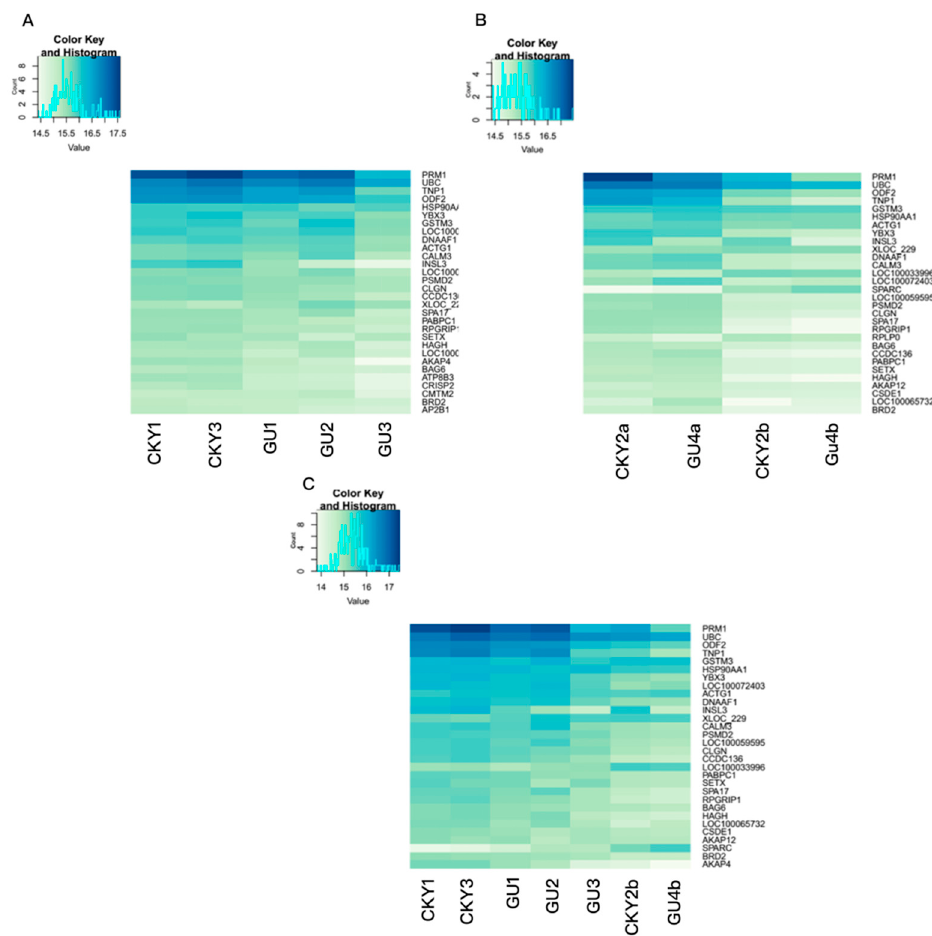
Figure 2. Top 30 genes expressed in horse testicular tissue. ( A ) Gene expression in Guanzhong and Chakouyi horses. ( B ) Gene expression in DTs and UDTs of cryptorchids. ( C ) Gene expression in DTs of normal horses and UDTs of cryptorchids.